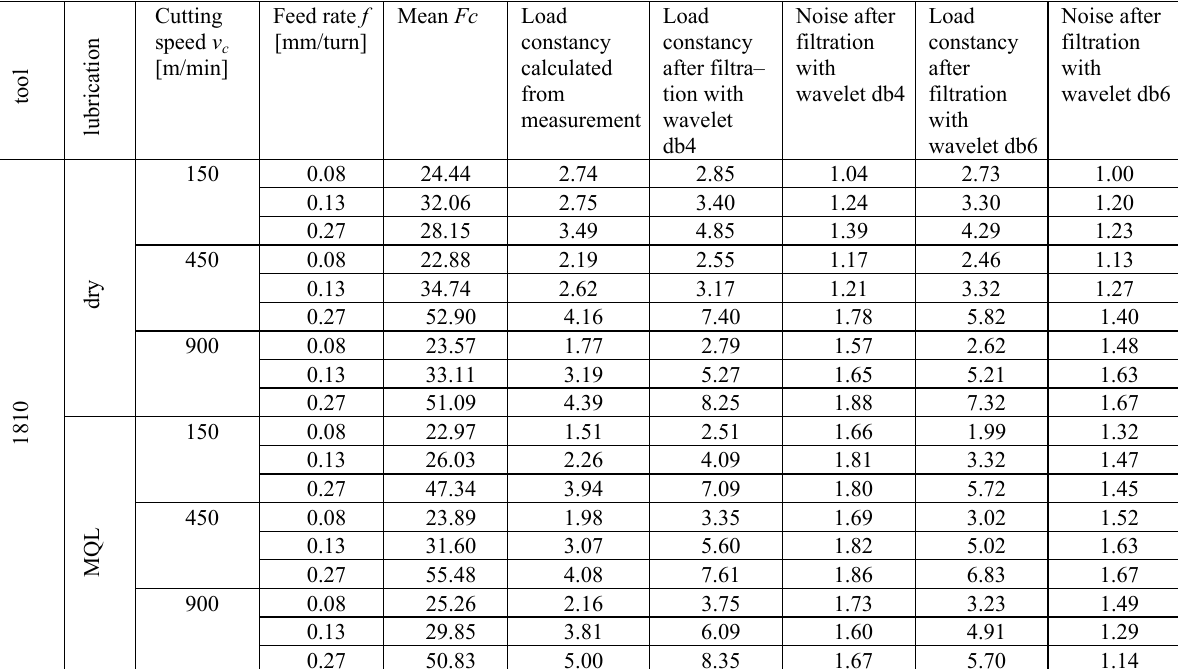
Table 5. Measured cutting forces Fc , measurement-based load constancy factor values and after filtration with wavelets and noise values for aluminium composite turning with diamond coated carbide